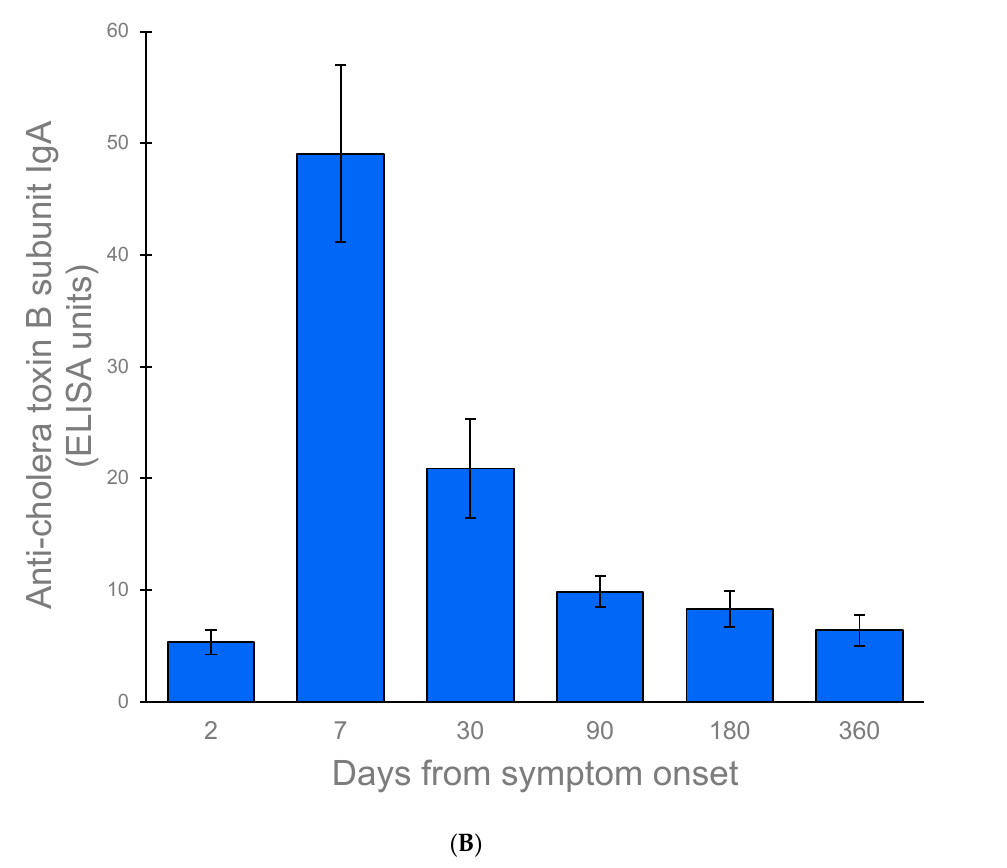
Figure 2. ( A ) Forest plots of the kinetics of anti-cholera toxin B subunit IgA following cholera [37–40,42,43]. ( B ) Kinetics of anti-cholera toxin B subunit IgA following cholera. On day 360, the anti-CTB IgA titer returned to levels comparable to those seen during an acute infection.